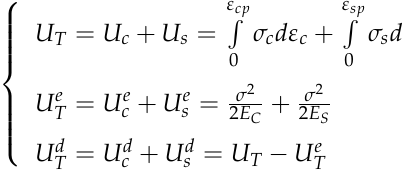
Figure 8. Deformation model of coal–rock assemblage. ( a ) Composite coal–rock deformation diagram; ( b )strain test results of composite coal–rock mass.